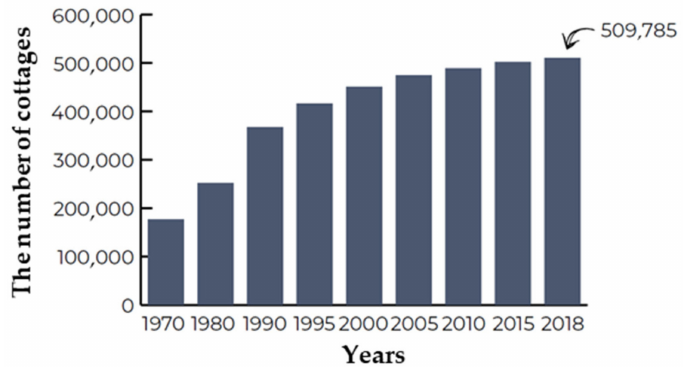
Figure 3. The number of cottages in Finland (1970–2018).